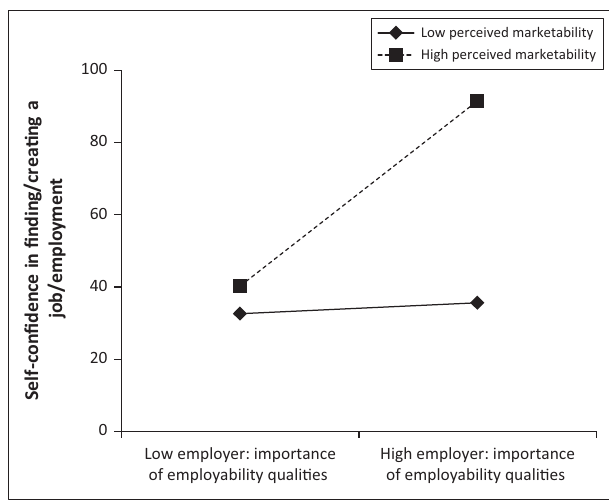
FIGURE 3: Interaction effects between perceived employer’s importance of employability qualities and perceived marketability in predicting self-confidence in finding or creating a job or employment.